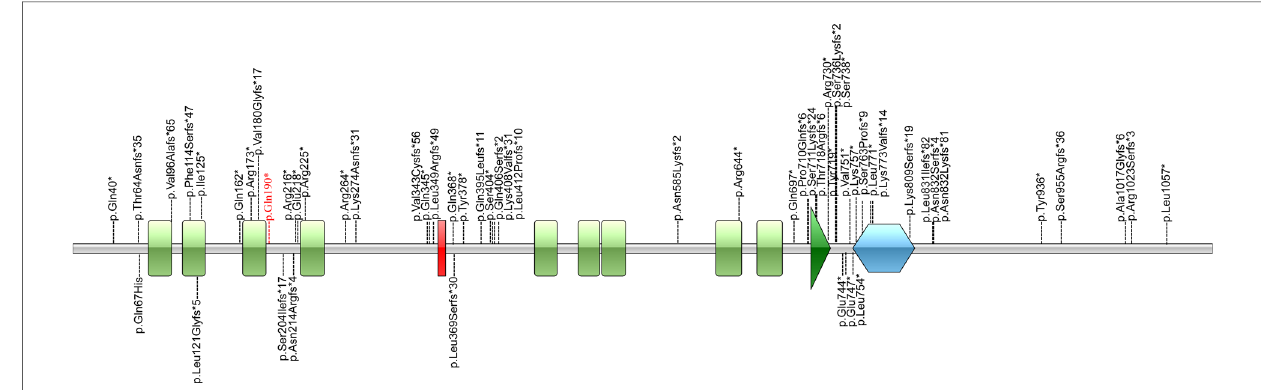
FIGURE 4 Illustrations denoting the mutant sites. Previously found varients in patients with HVDAS are depicted in black. The variants found in our patient p. Gln190* in red is the novel